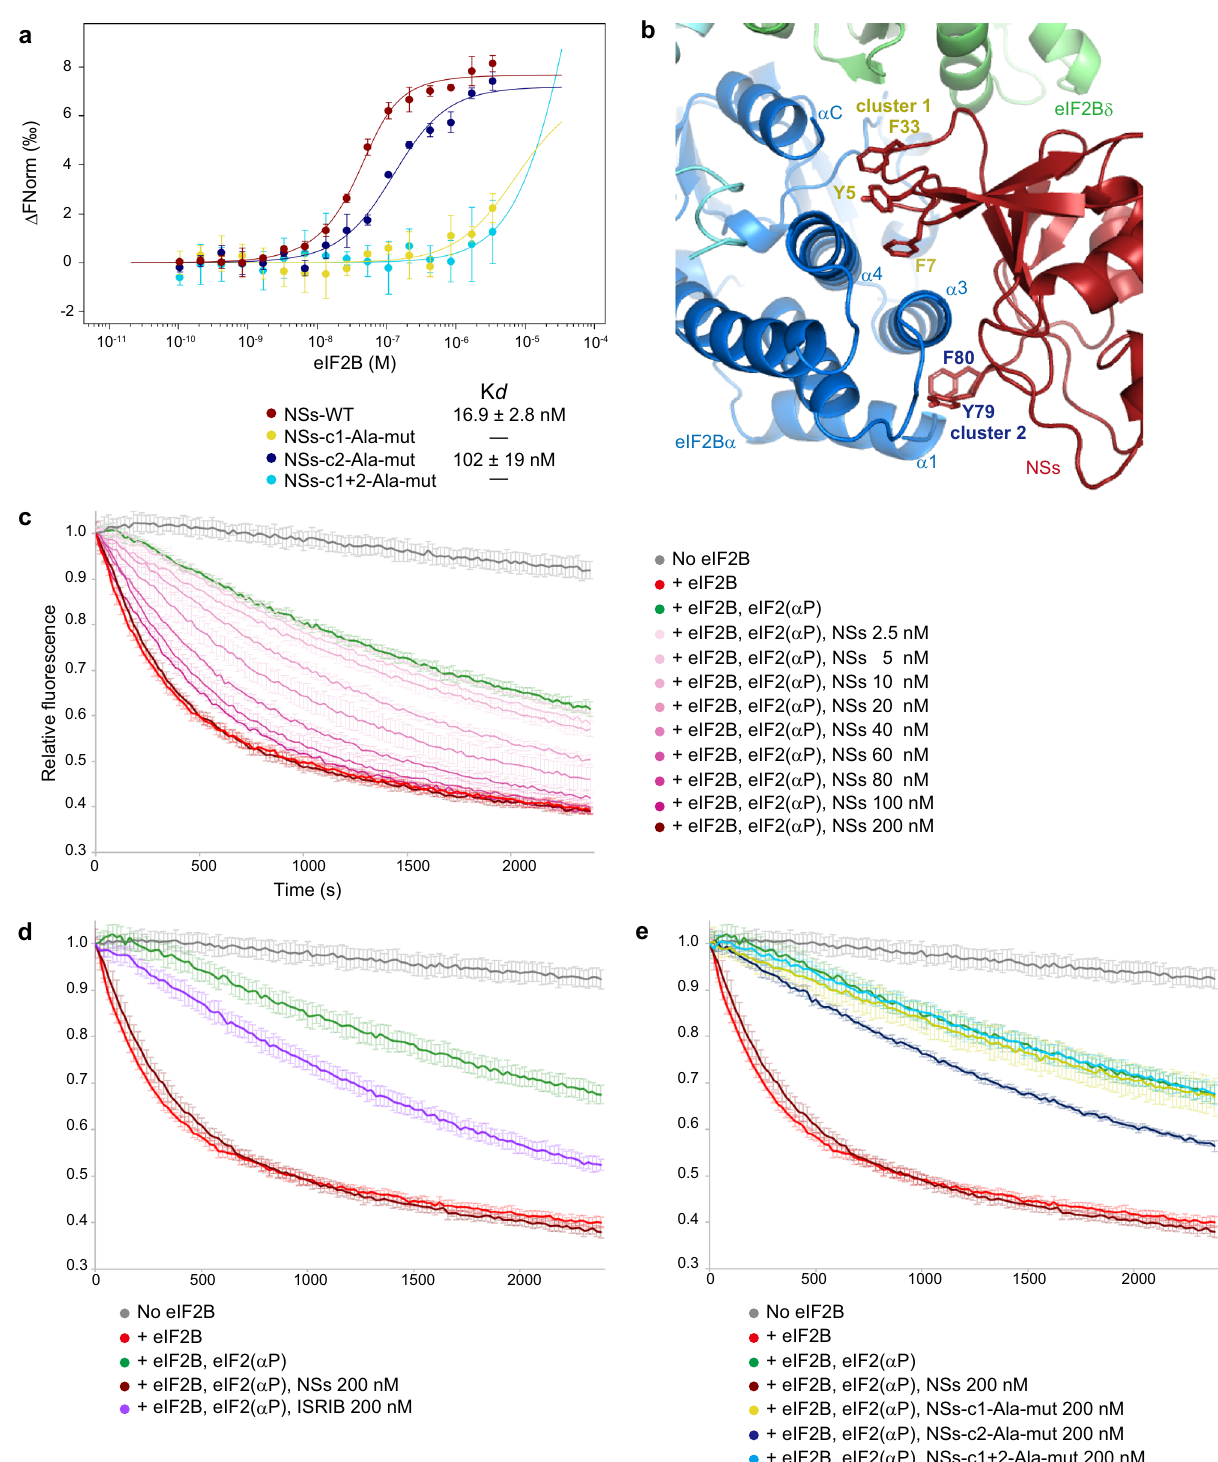
SFSV NSs attenuates the ISR in cellular contexts . The inhibition of eIF2B by eIF2( α P) results in a global reduction of protein synthesis. To observe the cellular effect of SFSV NSs on overall translation during stress, human embryonic kidney (HEK) 293 cells were treated with thapsigargin (Tg) to induce endoplasmic reticulum (ER) stress, activate PERK, and lead to the eIF2 α phosphorylation and consequently the ISR. The Tg treatment shut off global translation, as monitored by the metabolic